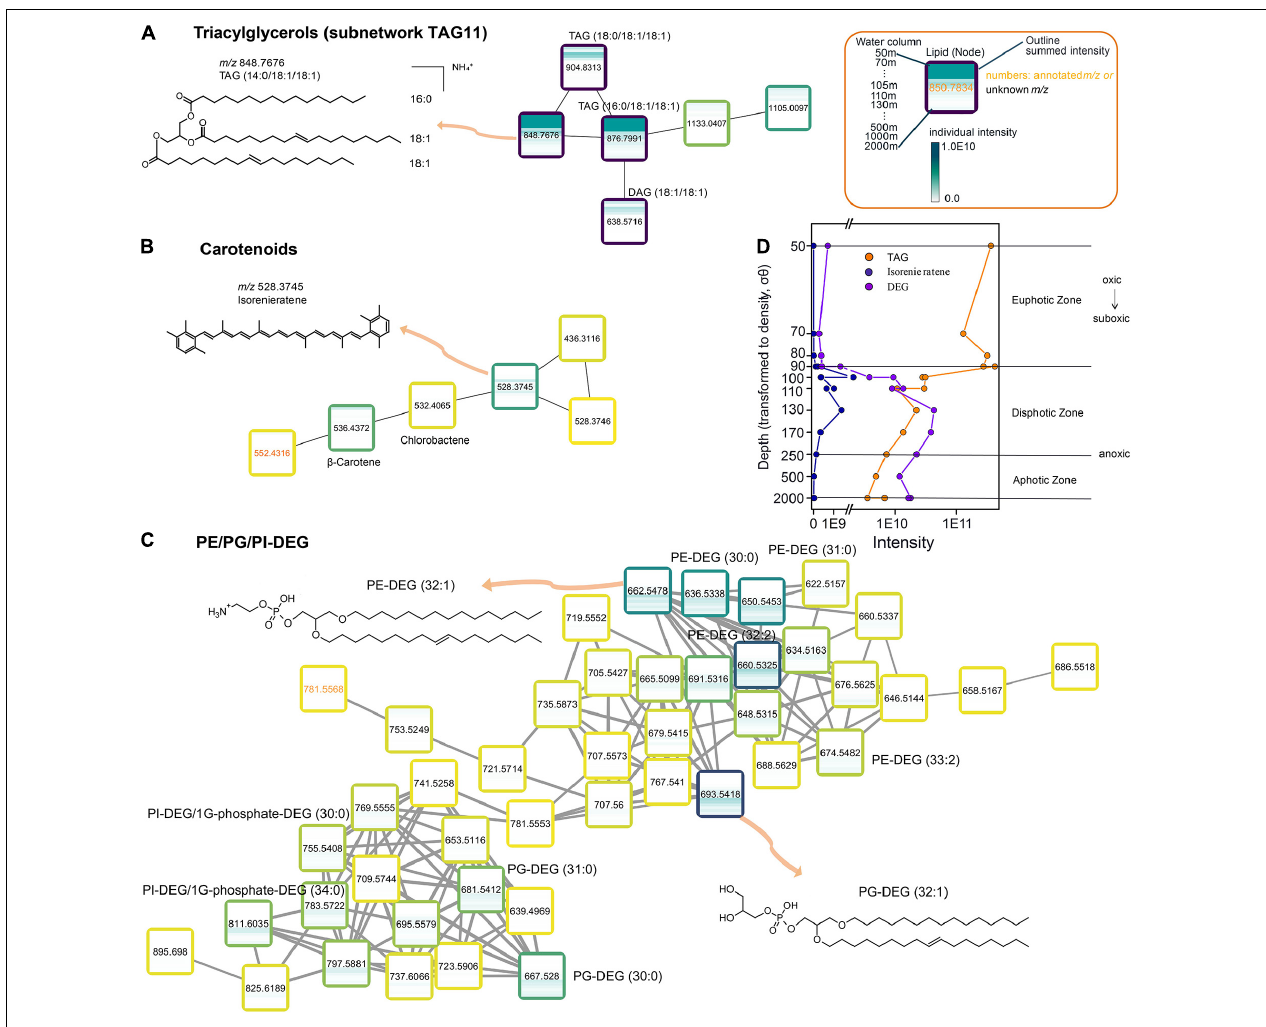
FIGURE 3 | Molecular subnetwork of specific lipid classes determines the photic and aerobic zone in the Black Sea. (A) Subnetwork of triacylglycerol 11. (B) Part of subnetwork of carotenoid. (C) Subnetwork of PE/PG/PI-DEG. (D) Distribution and stratification of the summed intensity of TAG, isorenieratene and DEG in the water column of the Black Sea (50–2,000 mbsl). The names of these selected lipid classes are linked to the ones in the major network ( Figure 2 ). Boxes shown here are the same as nodes shown in Figure 2 , representing lipid species. The outlines of the boxes are labeled from light yellow to dark blue with the increasing of the summed intensity among all the water column samples (15 depths). Inside the box, a heatmap represents the distribution of this lipid species across the water column, from top (50 mbsl) to bottom (2,000 mbsl). The lipid components with closely related masses (e.g., m/z 707.5600 vs. 707.5573, C ) have similar mass spectra but different retention time (20.9 min vs. 20.3 min), suggesting they are structural